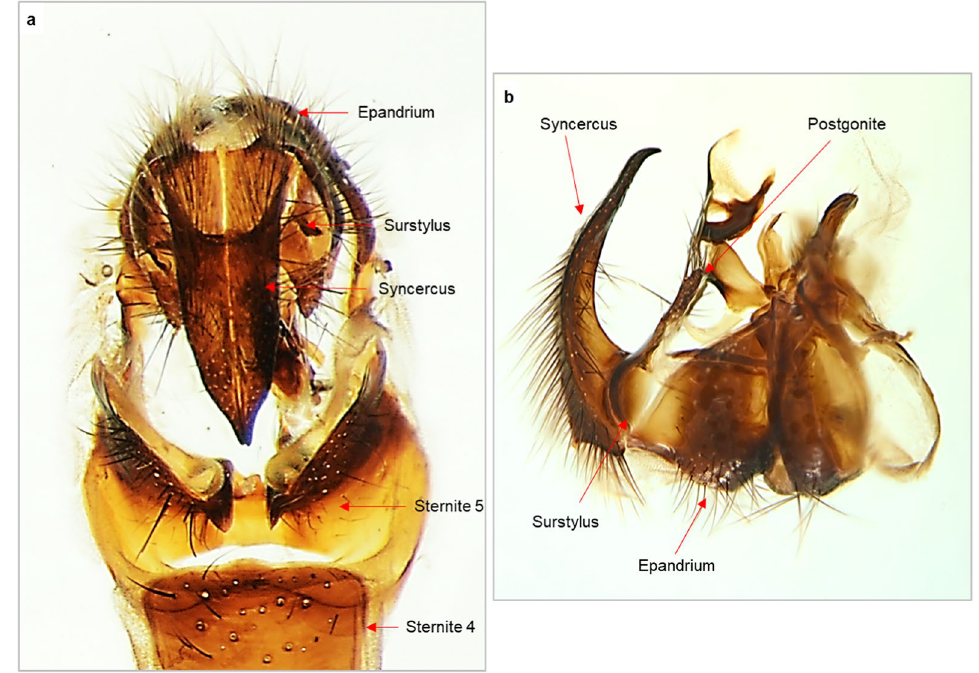
Fig. 2 Male terminalia of E. segregata ; a ventral view; b lateral